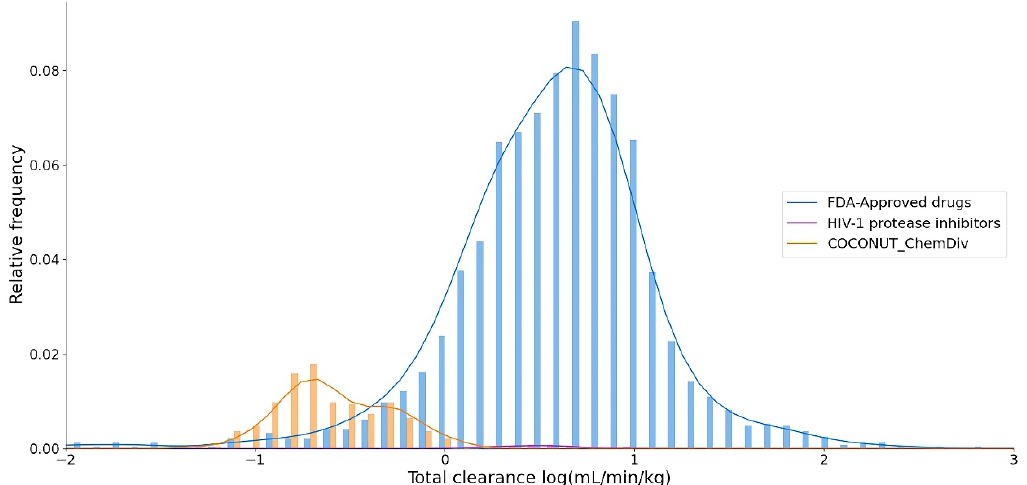
Figure 14. Distribution curve of the total clearance. Colors represent compounds: new chemical compounds generated from COCONUT fragments and ChemDiv fragments with physicochemical properties like FDA-approved HIV-1 protease inhibitors and easily synthetically accessible (orange), FDA-approved drugs (blue), FDA-approved HIV-1 protease inhibitors (purple).